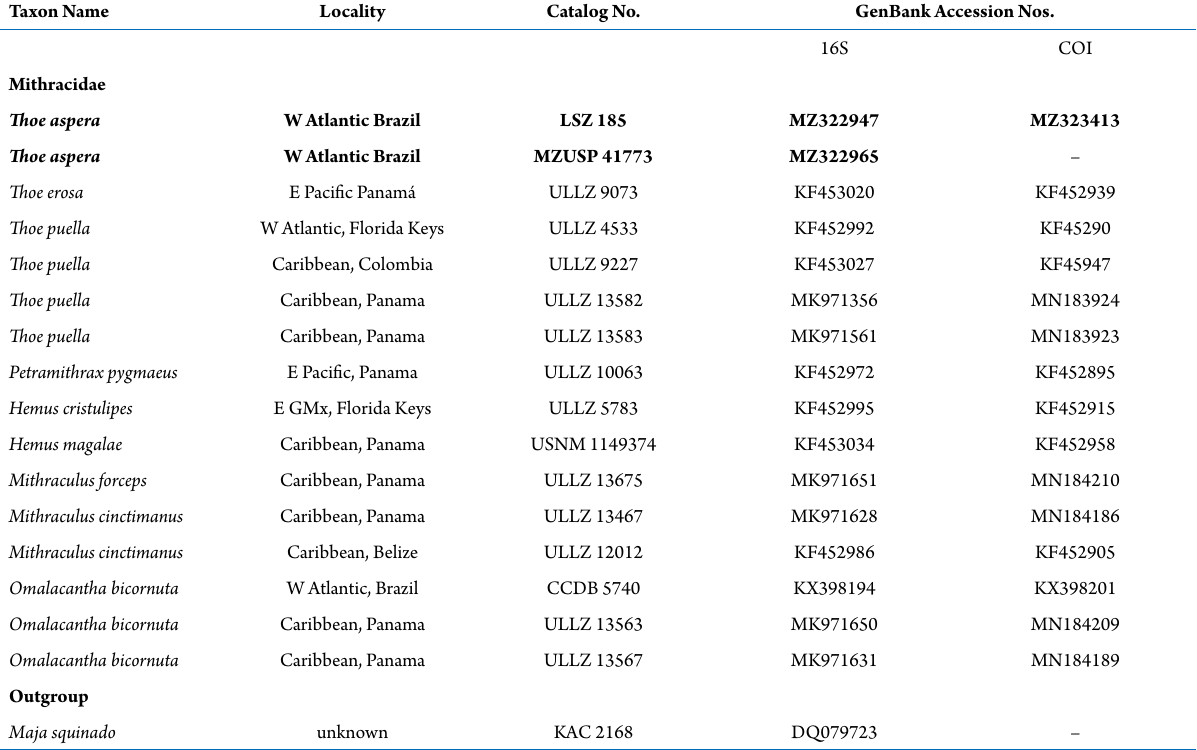
Table 1. Taxa included in the molecular phylogenetic and genetic distance analyses. Newly sequenced specimens are in bold. Abbreviation of institutional collections: CCDB, Coleção de Crustáceos do Departamento de Biologia - FFCLRP, Universidade